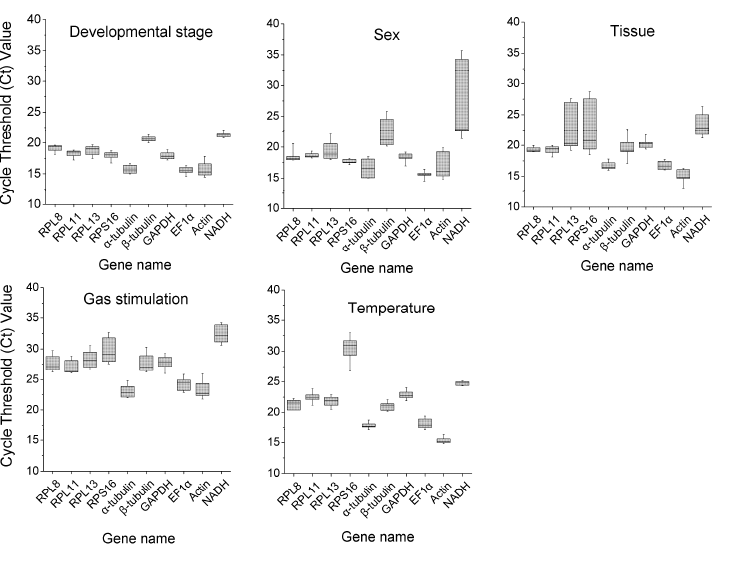
Figure 1. Cycle threshold (Ct) values of 10 candidate reference genes in C. hemipterus under different experimental conditions. The boxes show the 25th and 75th percentiles, the line inside the box depicts the median value, and whiskers indicate the standard error of the mean. Table 2. Cycle threshold (Ct) values (mean ± SE) of 10 candidate reference genes under five different experimental conditions.